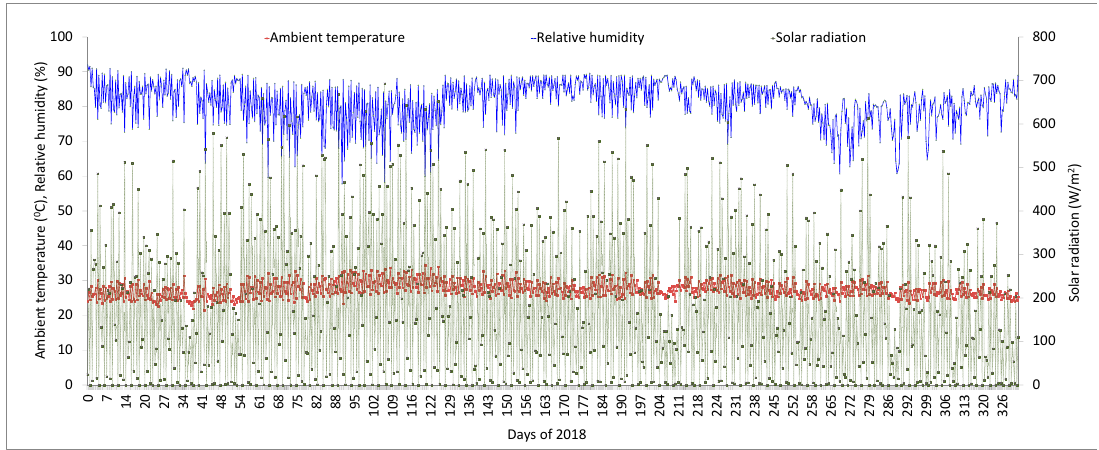
Figure 2. Ambient temperature, RH, and solar radiation in Los Baños, Philippines in 2018 (data were collected by the UPLB National Agromet Station).